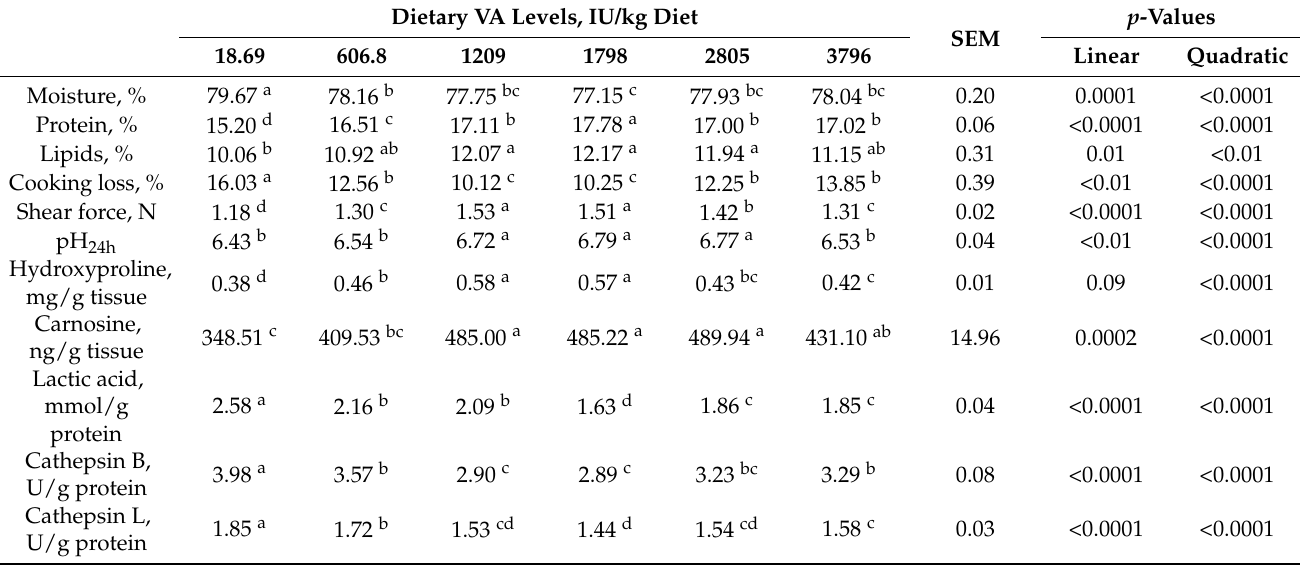
Table 3. Effects of dietary vitamin A on muscle proximate composition and physicochemical charac- teristics of on-growing grass carp 1 .